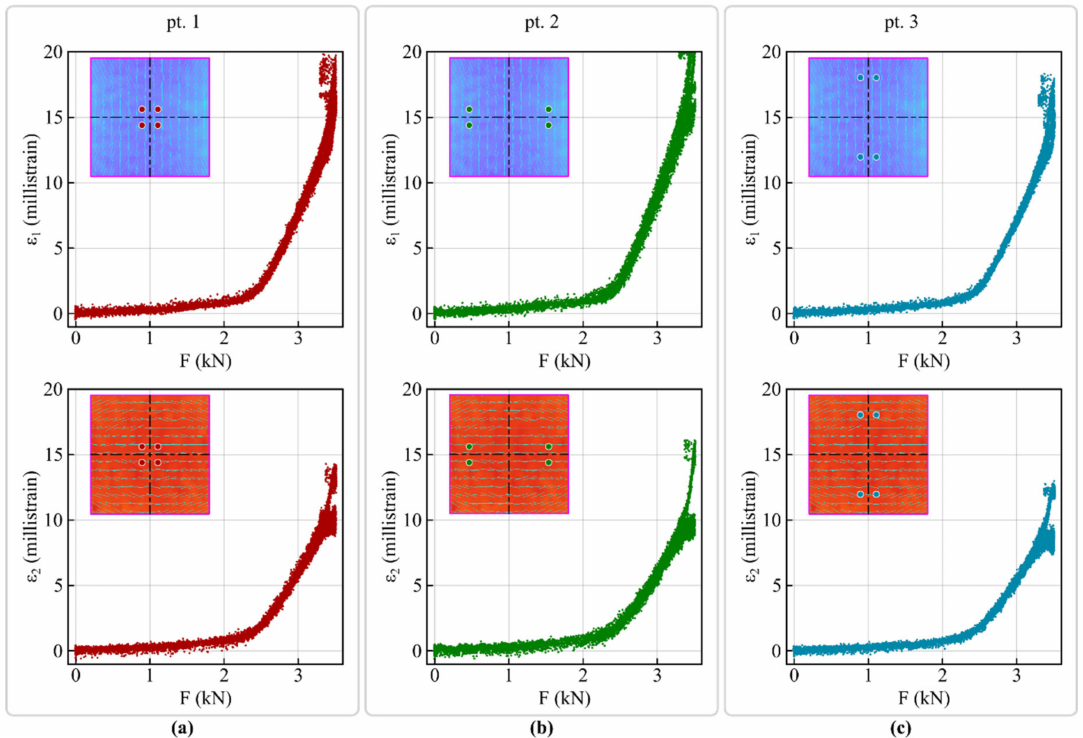
Figure 5. Characteristic measurements of heterogeneous specimen response: ( a ) max. / min. strain–force response at the close-to-centre points (pt. 1), ( b ) max. / min. strain–force response at the horizontal far-from-centre points (pt. 2), ( c ) max. / min. strain–force response at the vertical far-from-centre points (pt. 3). Blue and red insets in the figure represent the central region in Figure 4b,c, whereas the acquisition points are coloured red, green and blue. Short cyan lines represent the direction of a principal